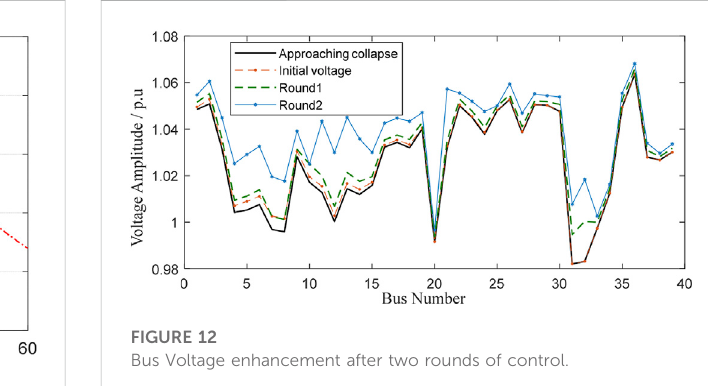
FIGURE 12 Bus Voltage enhancement after two rounds of control.